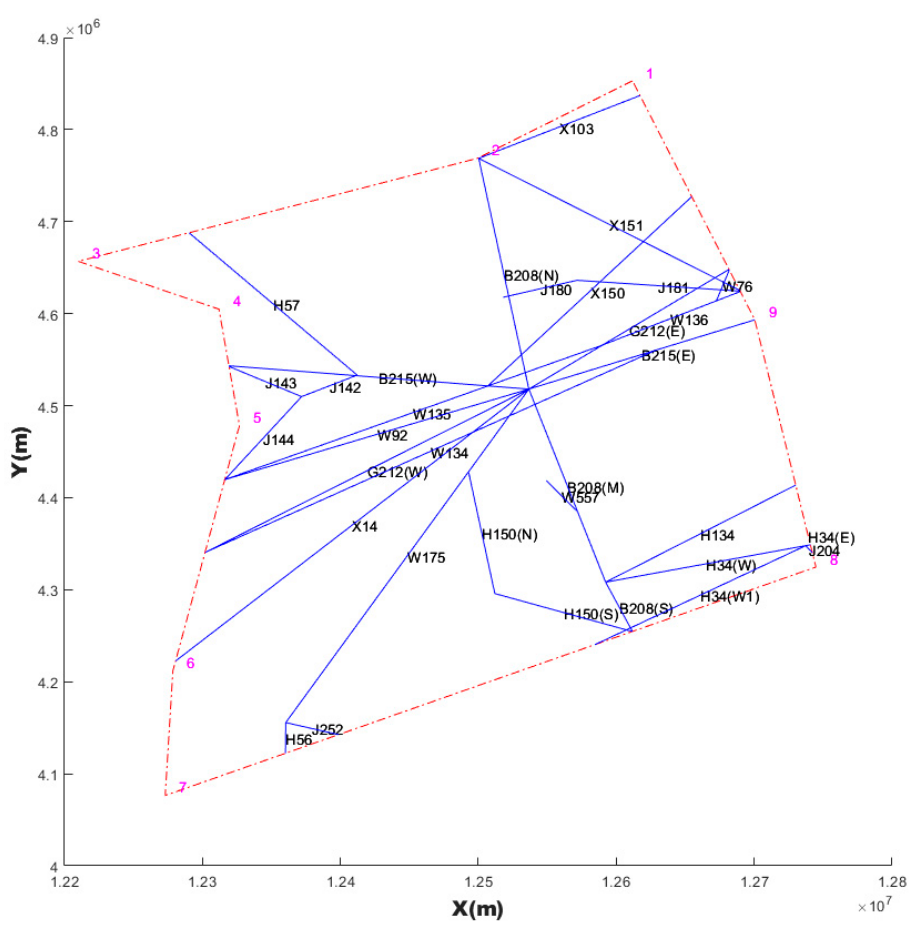
Figure 2. Route network and boundary in TYN airspace.